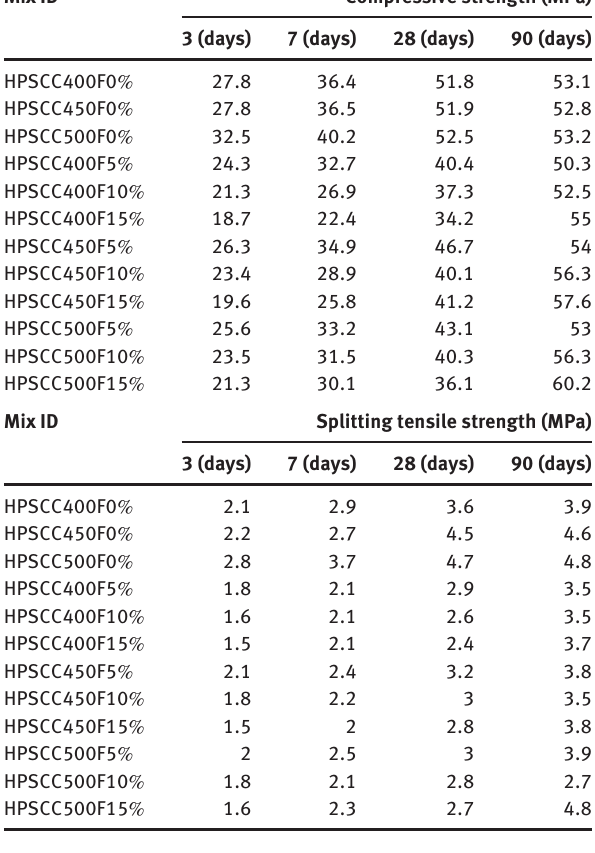
Table 8 Compressive and splitting tensile strength results of HPSCC